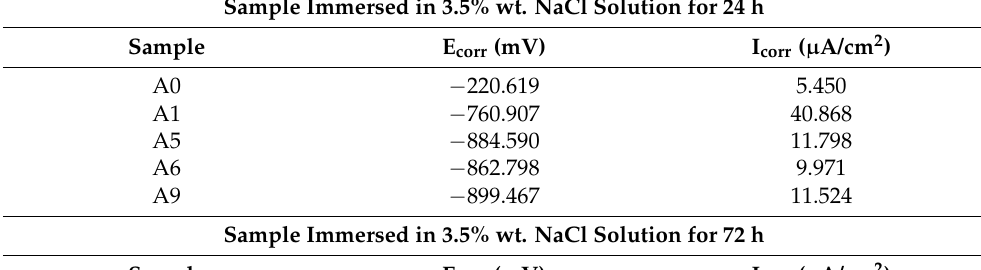
Table 3. Corrosion parameters from PDP curves for samples in NaCl